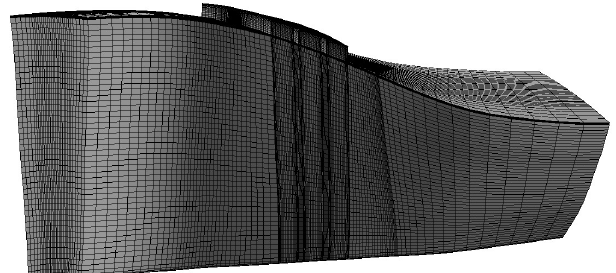
Figure 3. Computational mesh and grid system of rotor